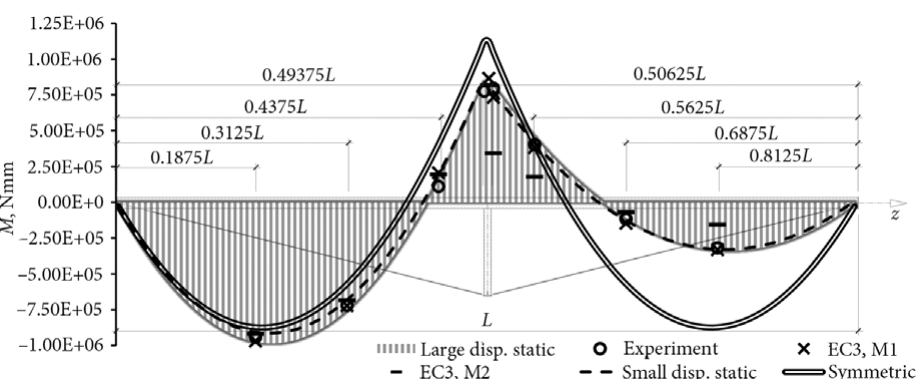
Fig. 7. Results of the UGB flexural response under Test B